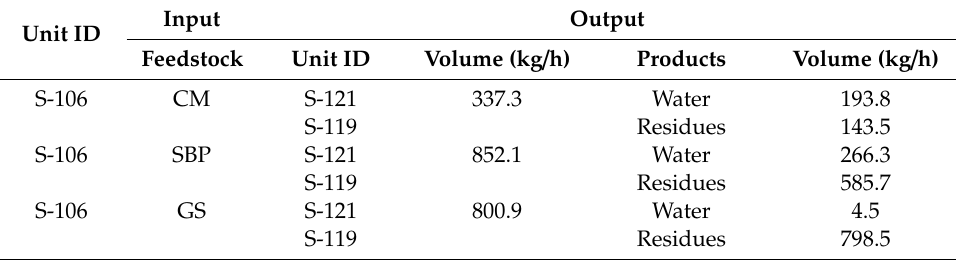
Table 3. The input and output of stage 2 for the feedstocks CM, SBP, and